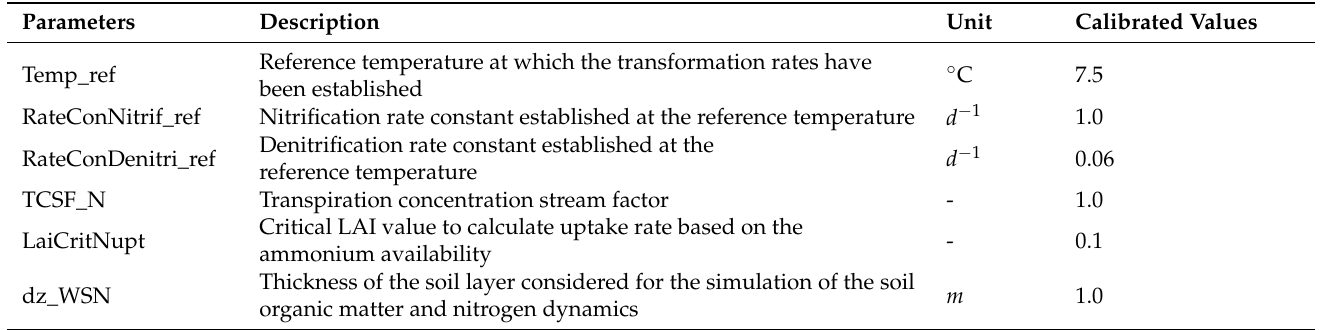
Table A4. Soil-N